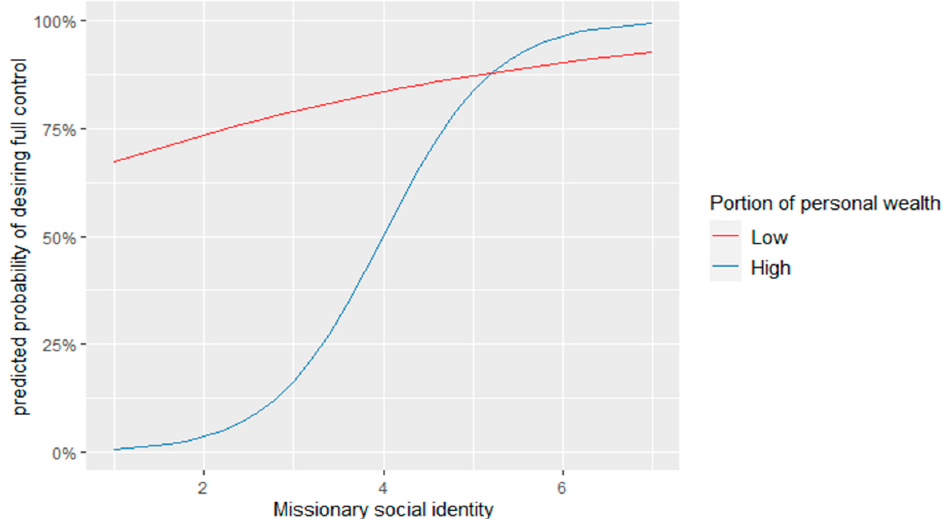
Figure 1. Interaction of portion of personal wealth and entrepreneurs’ missionary social identity for the desire to have full control. Note: With portion of personal wealth low = mean − S.D., and high = mean +